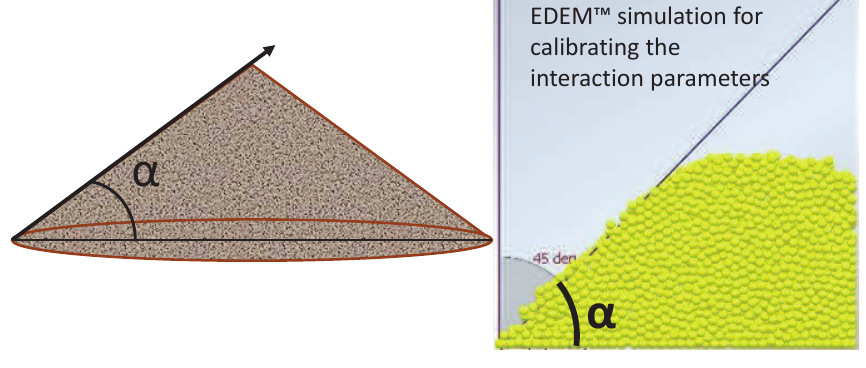
Figure 2. Angle of repose for API